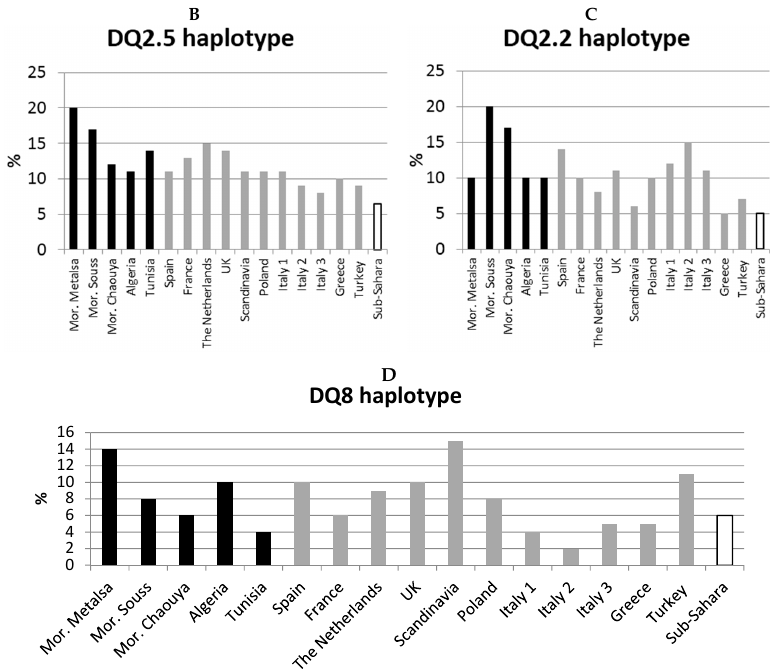
Figure 2. DQ2 and DQ8 haplotype distribution in African and European populations. ( A ) DQ2 haplotype frequencies; ( B ) DQ2.5 haplotype frequencies; ( C ) DQ2.2 haplotype frequencies; ( D ) DQ8 haplotype frequencies. In black: Maghreb populations. In grey: Mediterranean and European populations. In white: Sub-Saharans (average frequency of three populations). References: Mor. = Morocco (Metalsa) [3]; France, Scandinavia, Italy 2 [8]; Greece [12]; Morocco (Souss), Morocco (Chaouya), Algeria, Tunisia, Turkey, Sub-Sahara (Cameroon, Congo, Gabon) [15]; Italy 1 [16]; Spain,